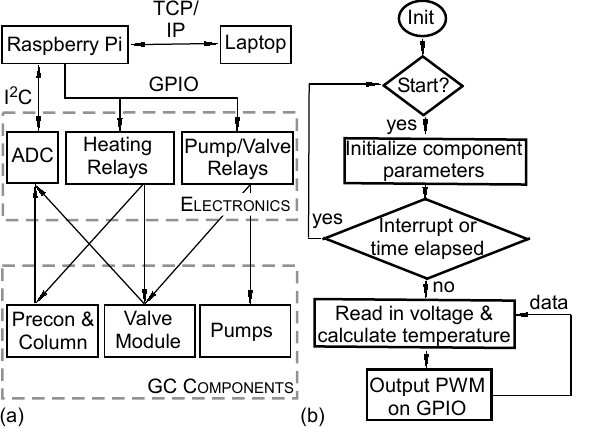
Figure 4. ( a ) Electrical connections between the microcontroller, the laptop with the user interface, the integrated circuits, and the GC components. ( b ) The flow chart of the control software illustrating closed-loop temperature control of the